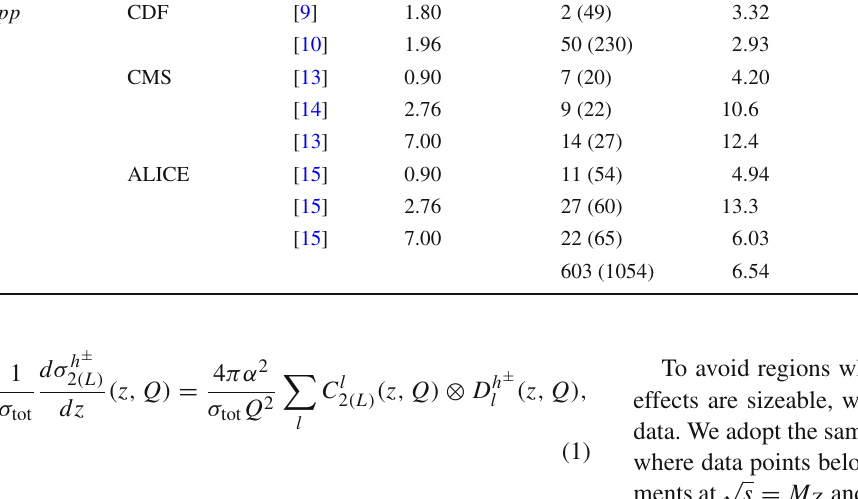
/ N χ 2 / N (after) reweighting, χ 2 dat ( dat ), the number of effective repli- rw in cas after reweighting, N eff , and the modal value of the P (α) distribu- tion in the range α ∈ [ 0 . 5 , 4 ] , argmax P (α) . For SIA experiments,